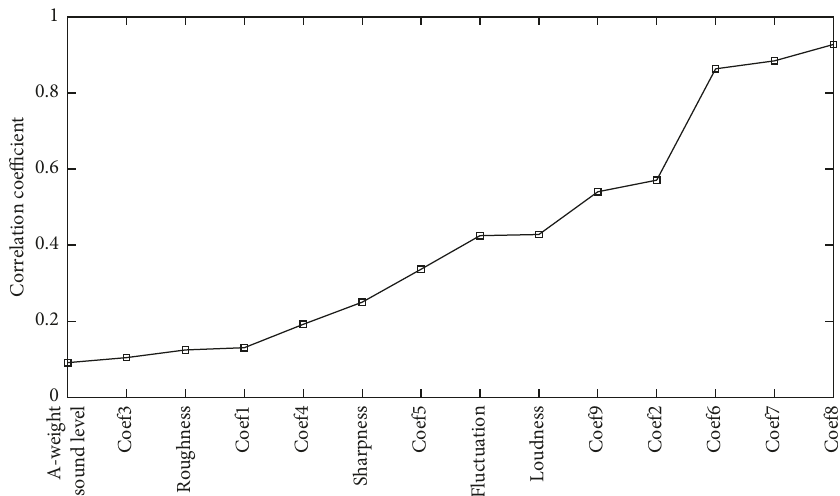
Figure 7: Correlation coefficient between objective parameters and subjective evaluation value.